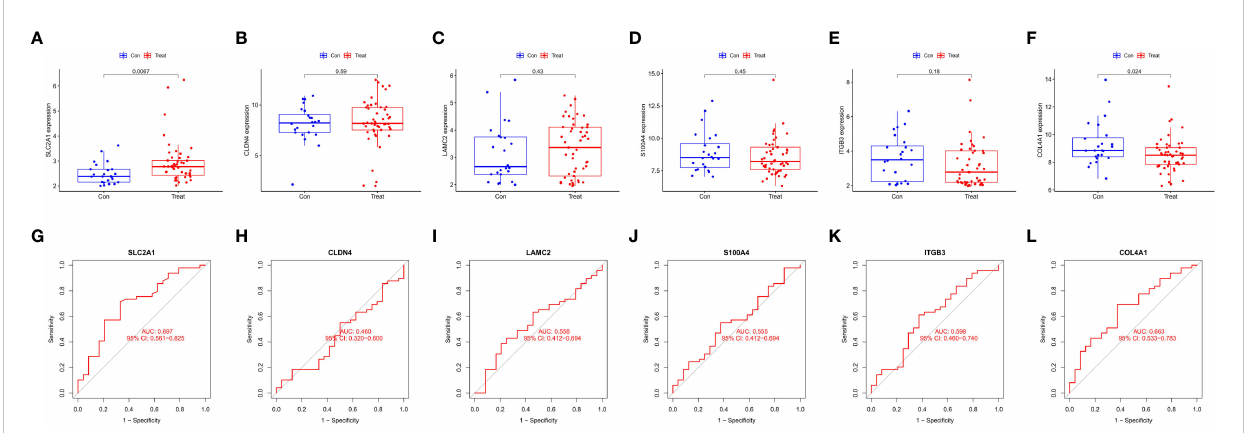
FIGURE 6 Correlation analysis of Key EMT-DEPs expression and invasiveness in GSE169498: (A) SLC2A1; (B) CLDN4; (C) LAMC2; (D) S100A4; (E) ITGB3; (F) COL4A1. ROC curve of Key EMT-DEPs predicting invasivity in GSE169498: (G) SLC2A1; (H) CLDN4; (I) LAMC2; (J) S100A4; (K) ITGB3; (L) COL4A1.